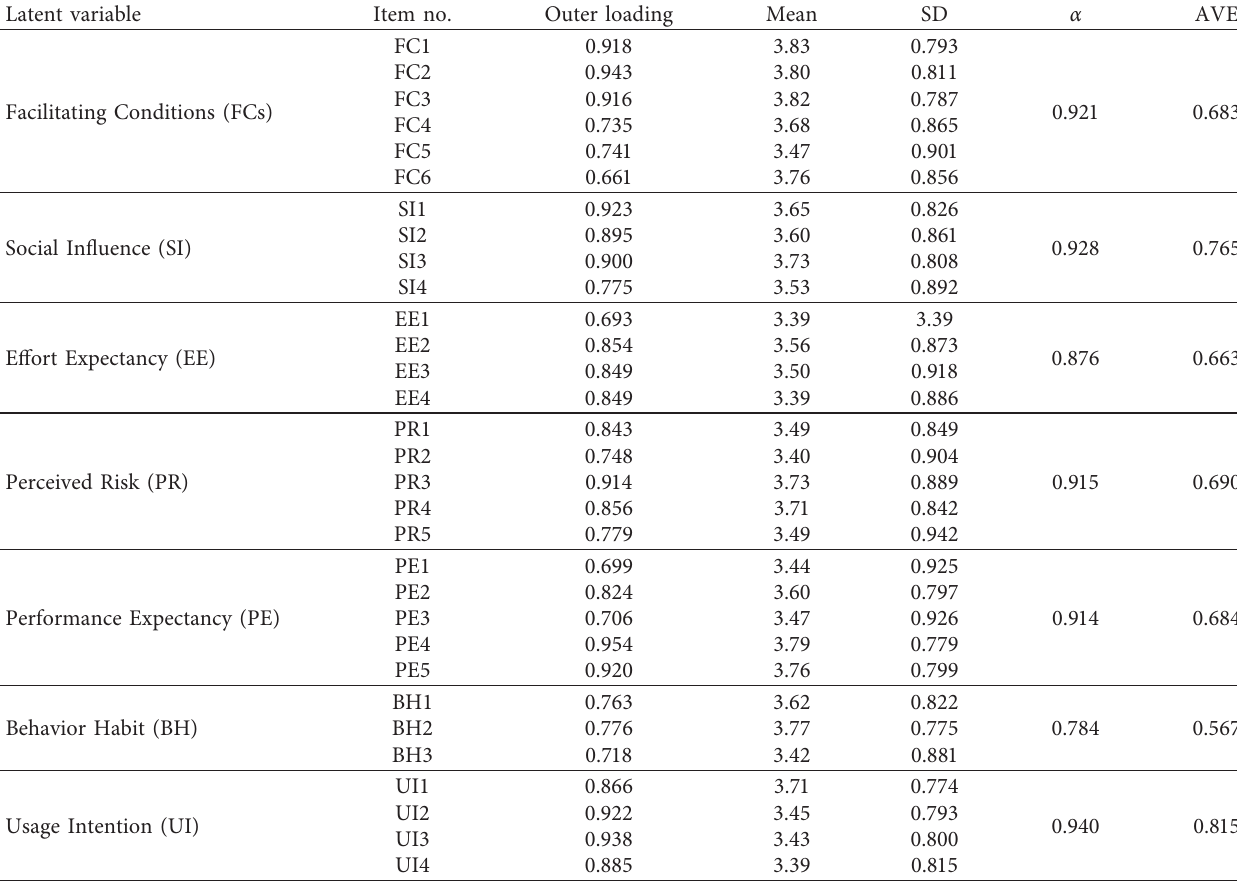
Table 3: Measurement items for all the relevant constructions.